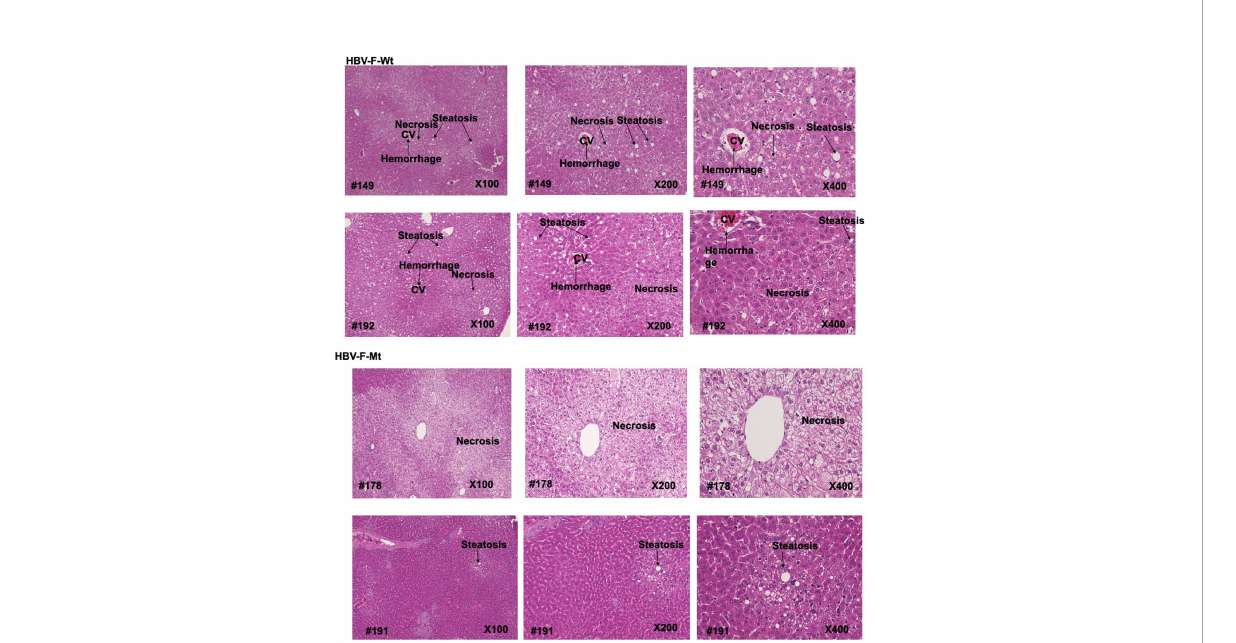
FIGURE 4 Histopathological analysis of liver tissues from uninfected control and HBV-F Wt/Mt-infected tree shrews at 14 dpi. Histopathological analysis of liver tissues from uninfected control and HBV-F Wt (#149, 192)/Mt (#178, #191)-infected tree shrews at 14 dpi. Histopathological analysis was performed with H&E. The images were taken using a BZ-X700 fl uorescence microscope (Keyence Co., Japan) at 100x, 200x and 400× magni fi